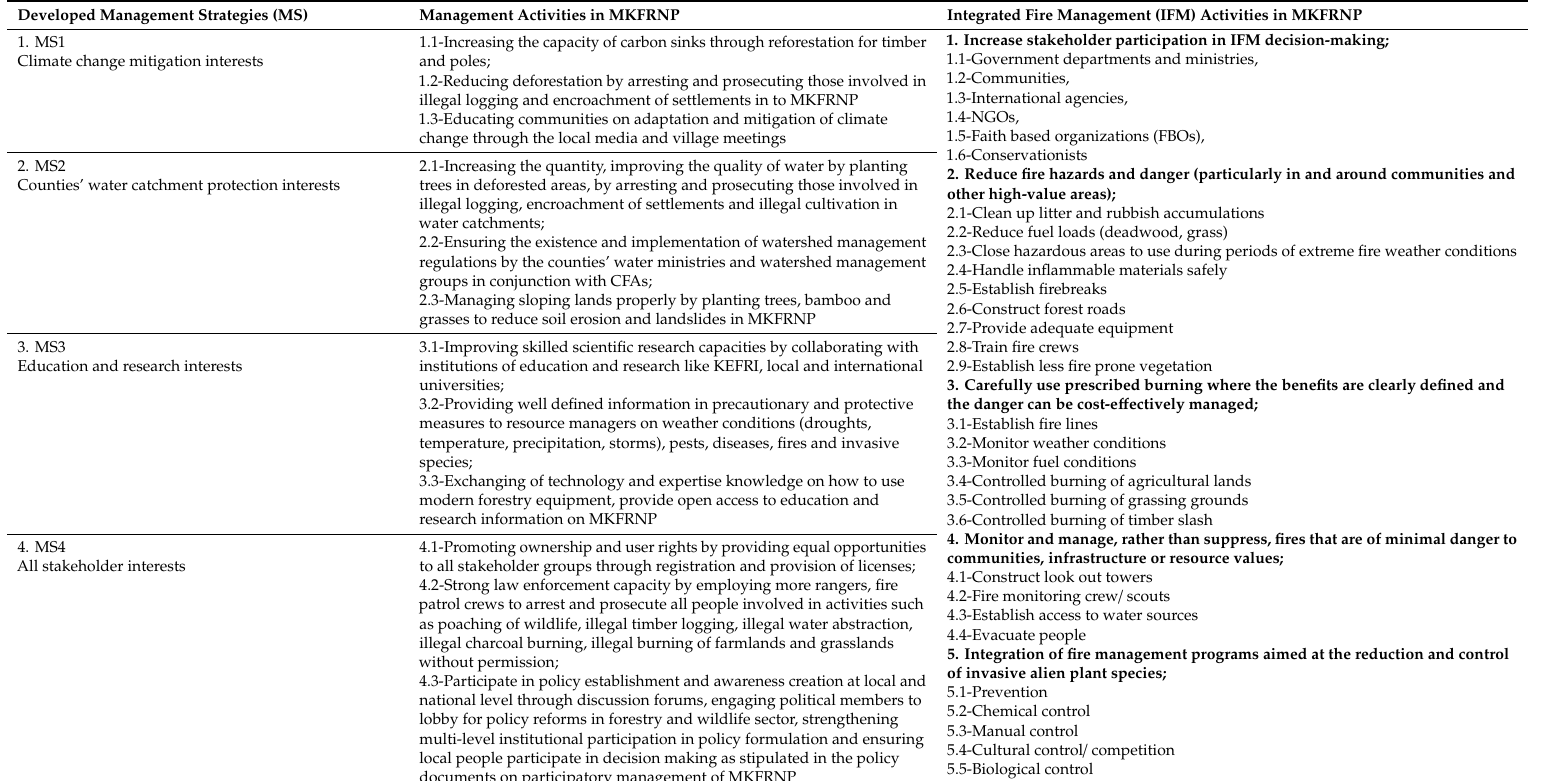
Table A1. Developed management strategies (MS) and the main activities that need to be implemented to reduce fire danger and increase the benefits obtained in